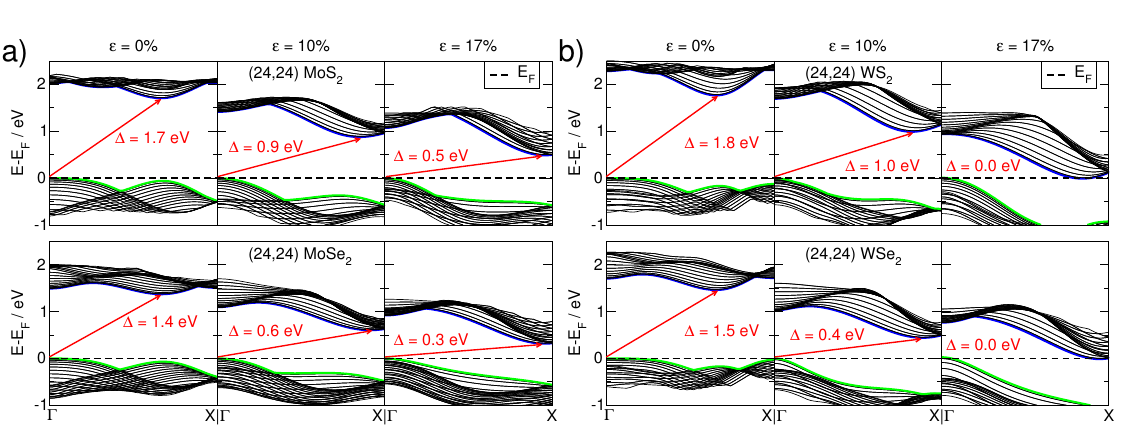
Figure 5. The calculated band structure response to the applied tensile strain of armchair TX NTs. ( a ) MoX and ( b ) WX . 2 2 2